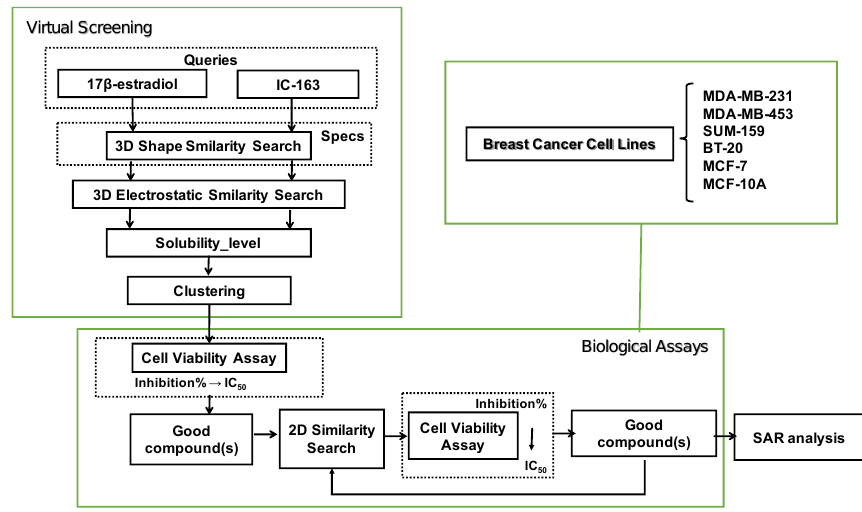
Figure 6. Workflow of virtual screening and bioassays.